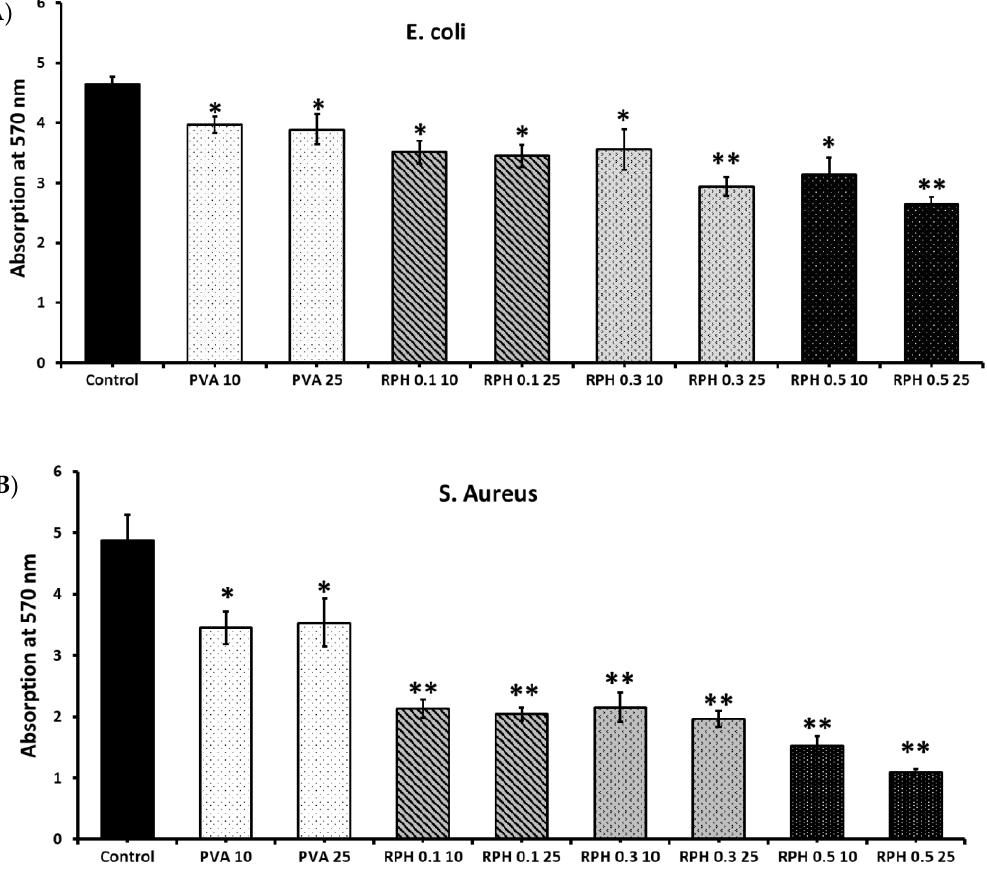
Figure 6. Microbial attachment of RPHX hydrogels with E. coli ( A ) and S. aureus ( B ) strains. Control strains treated without hydrogel, PVA solution 15 wt.%, RPH 0.1-0.1% retinol PVA, RPH 0.3-0.3% retinol PVA, RPH 0.5-0.5% retinol PVA. The numbers 10 and 25 correspond to strains treated with 10 μL and 25 μL of RPHX hydrogel, respectively . * represents statistical significance, * p < 0.05 vs. control, ** p < 0.001 vs. control.